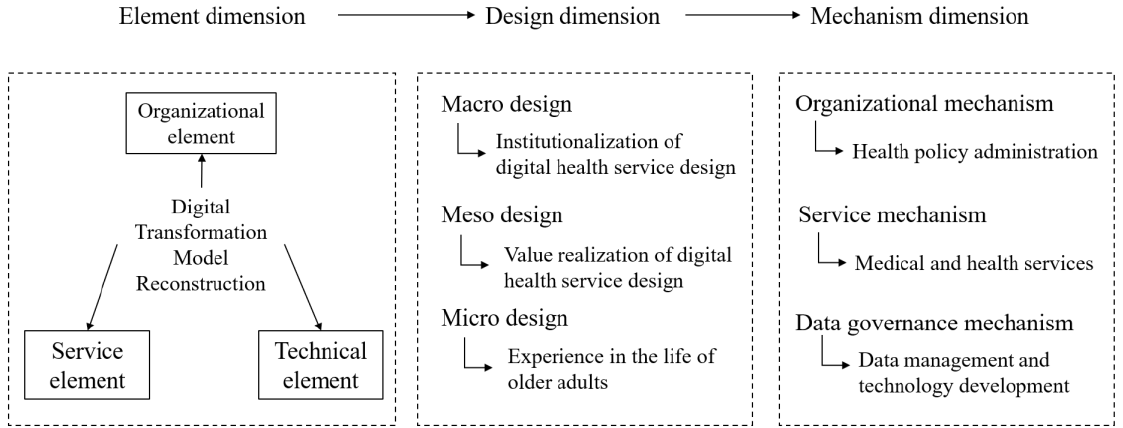
Figure 1. Framework for digital transformation of public health services.